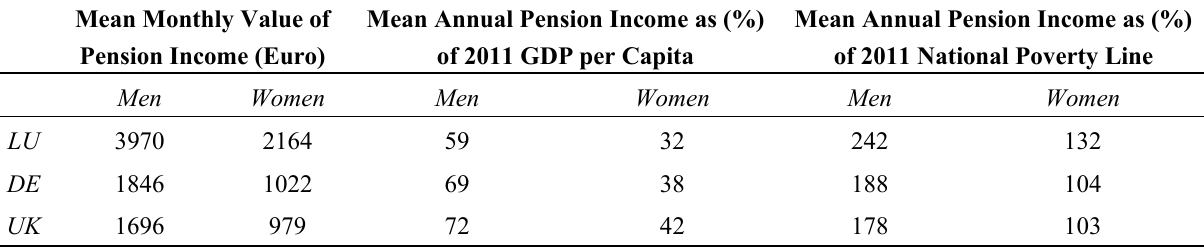
Table 1. Pension’s annual income mean values by gender in the EU (65–79 years old) (2012) 1 . Mean Monthly Value